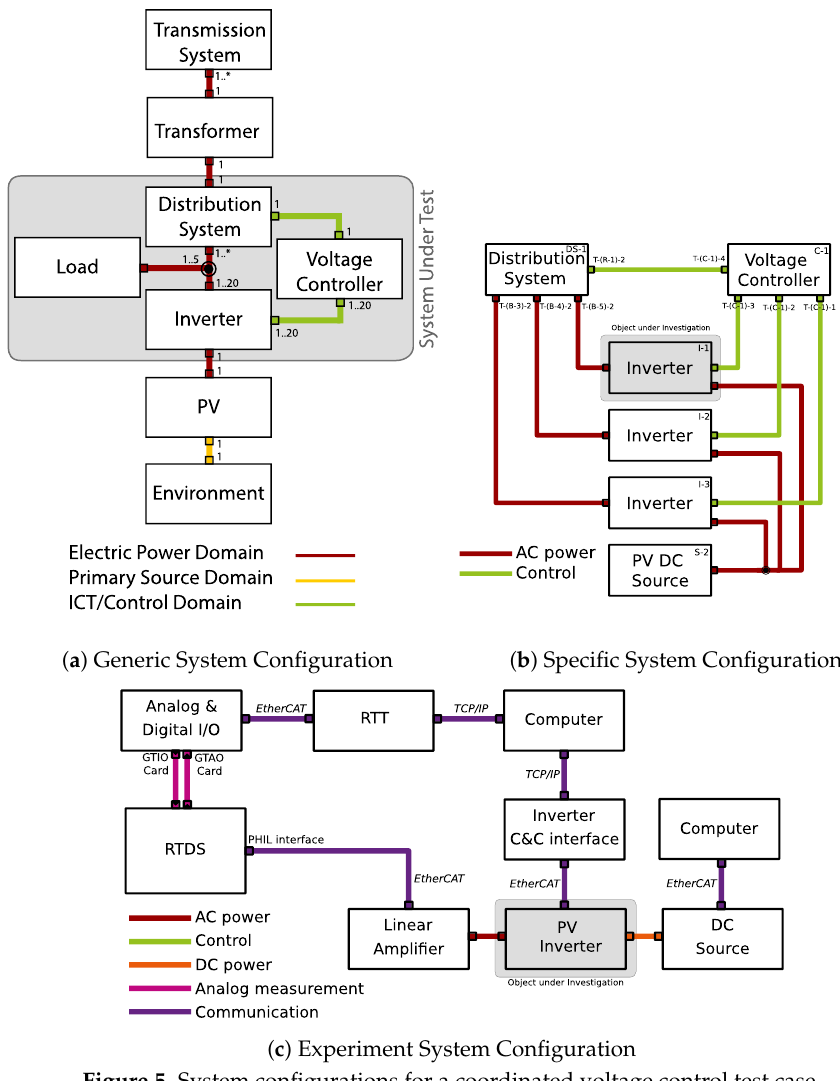
Figure 5. System configurations for a coordinated voltage control test